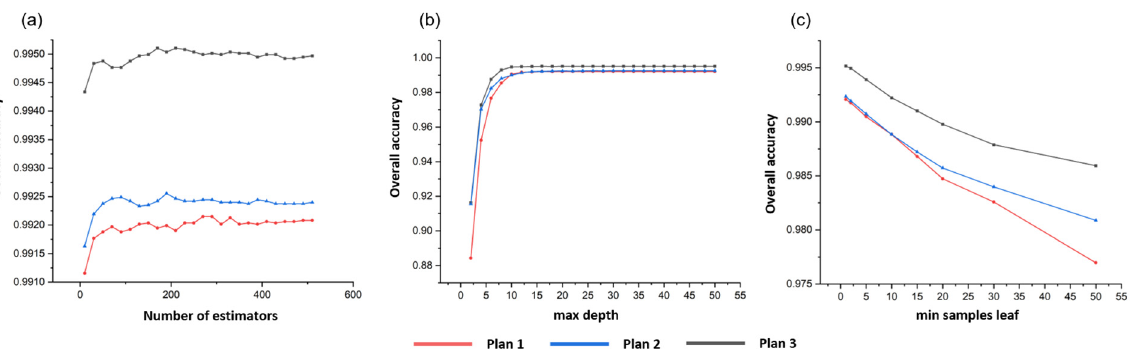
Figure 6. Conditioning curves of hyperparameters for the RF model. ( a ) Number of estimators; ( b ) max dept; and ( c ) min sample leaf.